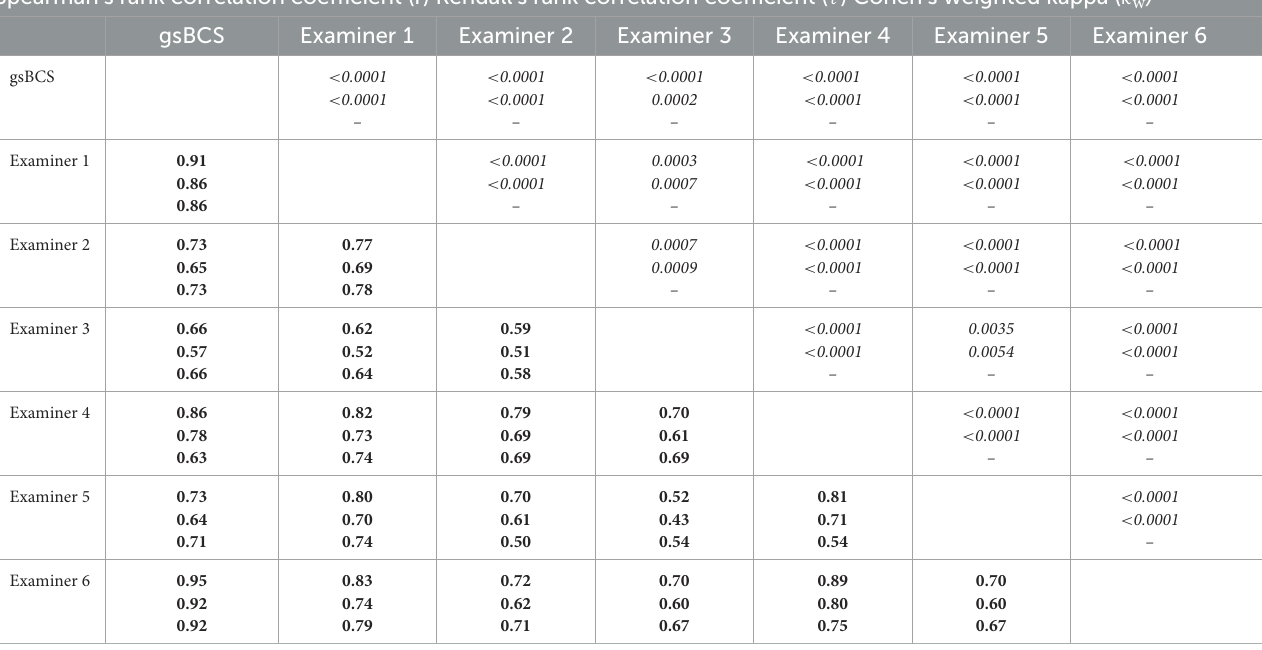
TABLE 3 Spearman’s rank correlation coefficient (r), Kendall’s rank correlation coefficient ( τ ), and Cohen’s weighted kappa ( κ w ) are listed in